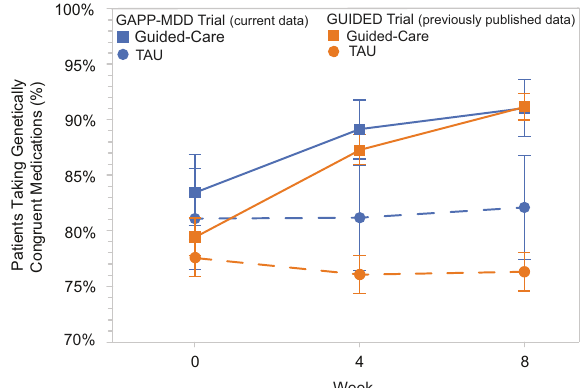
Fig. 2 Medication congruency by week in the Per-Protocol cohort of the GAPP-MDD clinical trial and the previous GUIDED trial [14]. The proportion of patients taking genetically congruent medica- tions from the GAPP-MDD and GUIDED trials are shown in blue and orange, respectively. Squares represent Guided-Care treatment arms, and circles represent TAU treatment